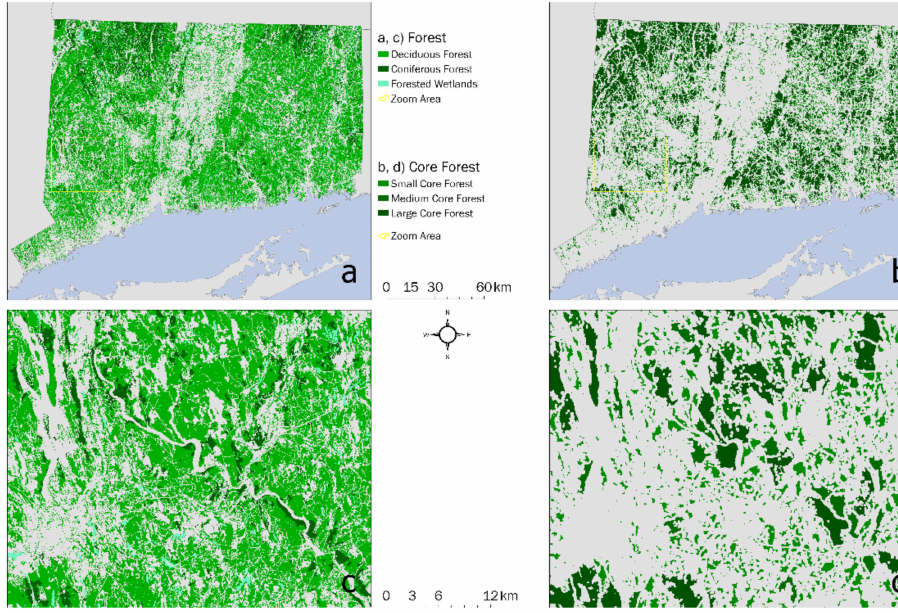
Figure 16. Forest cover versus core forest, 2015, for the whole state ( a , b ) and in closer detail ( c , d ).